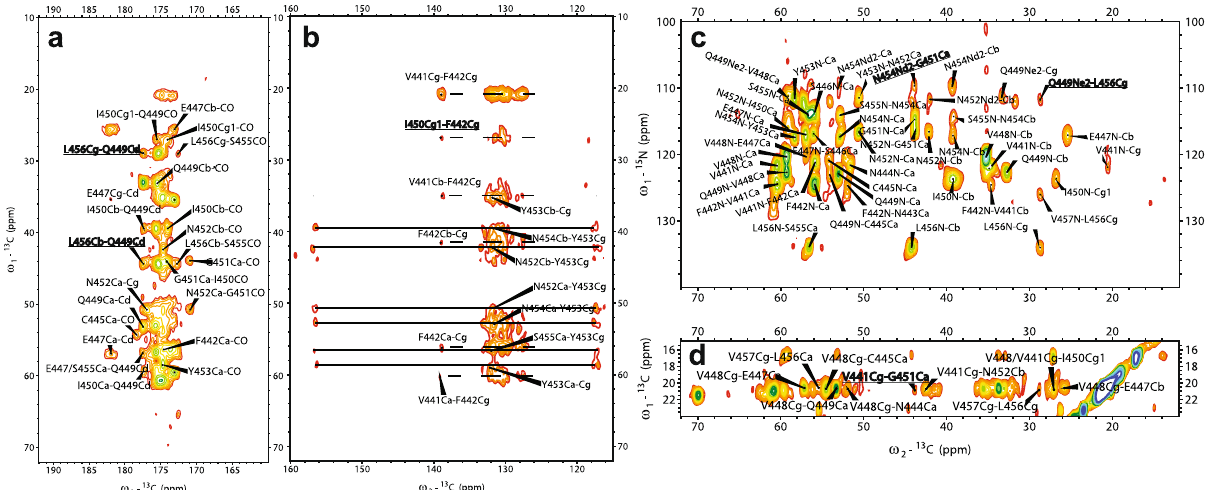
Fig. 5 SSNMR spectra of uniformly and sparsely 13 C-labeled mouse RIPK3 fi brils highlighting some long-range inter-residue correlation peaks. a 2D 13 C – 13 C correlation spectrum of sparsely 13 C-labeled mouse RIPK3 fi brils using [2- 13 C]-labeled glycerol with 200 ms DARR mixing, showing the carbonyl region. The long-range correlation peak L456C β /C γ -Q449C δ are highlighted. b 2D 13 C – 13 C correlation spectrum of uniformly 13 C-labeled mouse RIPK3 fi brils with 500 ms DARR mixing, showing the aromatic region. The dashed lines indicate the correlation peaks of F442, and the solid lines indicate the correlation peaks of Y453. c 13 C – 15 N TEDOR correlation spectrum of sparsely 13 C-labeled mouse RIPK3 fi brils using [2- 13 C]-labeled glycerol with 6.4 ms z- fi ltered TEDOR recoupling time. The protein is also uniformly 15 N-labeled. TEDOR shows the correlation peaks of N454N δ 2-G451C α and Q449N ε 2- L456C γ . d 2D 13 C – 13 C correlation spectrum of sparsely 13 C-labeled mouse RIPK3 fi brils using [1,3- 13 C]-labeled glycerol with 500 ms DARR mixing. The assignment of V441C γ -G451C α is unambiguous.